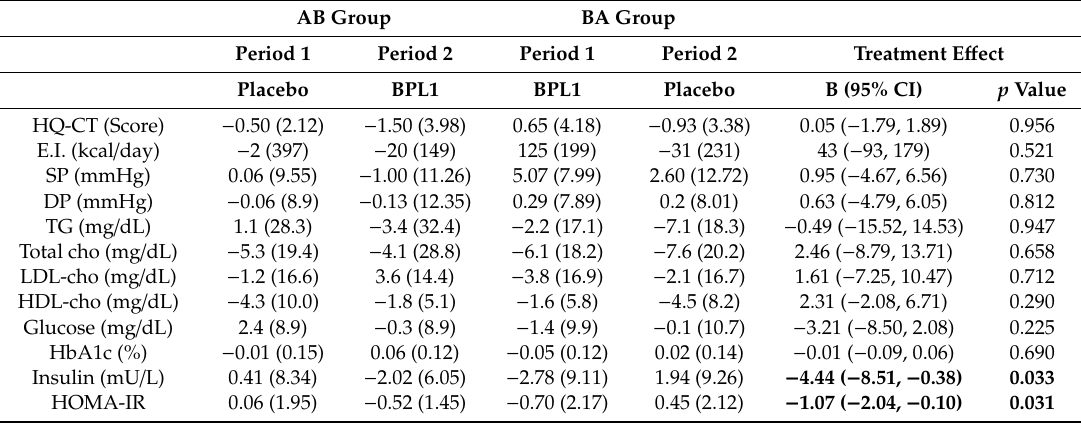
Table 3. Treatment e ff ects on hyperphagia and physiologic